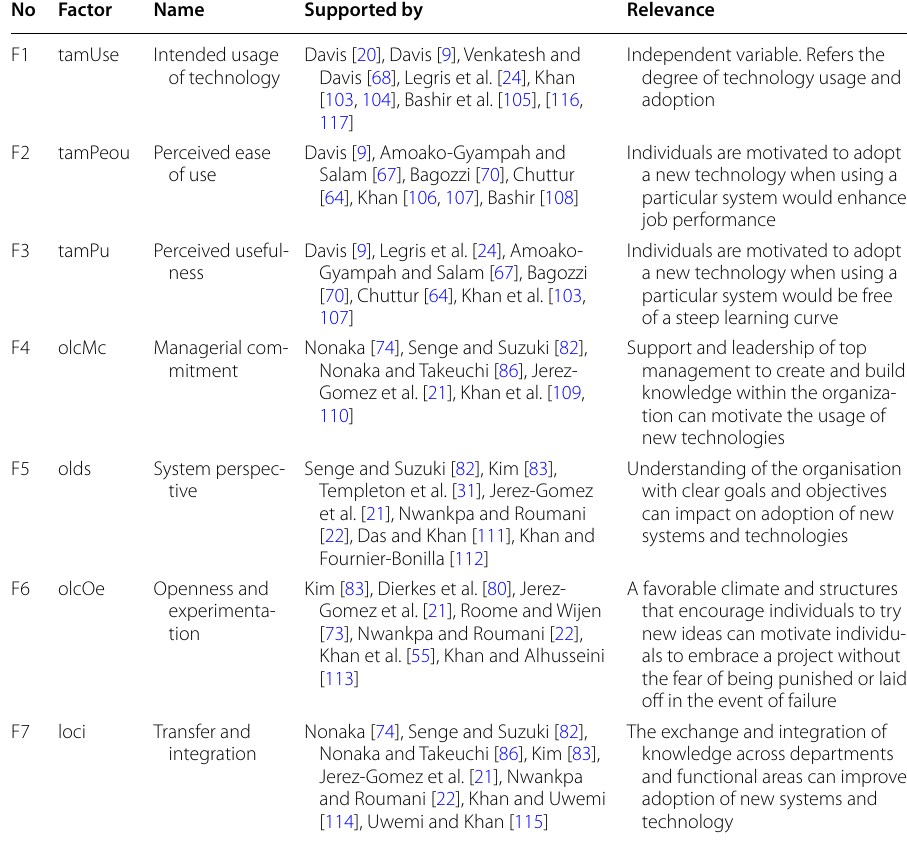
Table 1 Enabling factors for the research model No Factor Name Supported